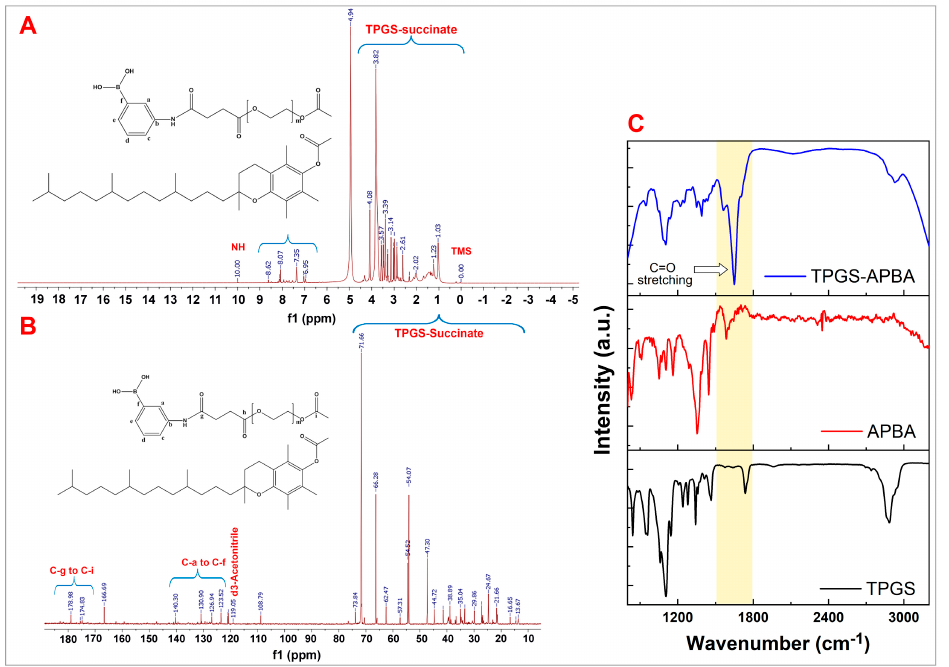
Figure 1. Characterization of functionalized TPGS using proton ( A ) and carbon ( B ) NMR (TMS— chlorotrimethylsilane). The right panel shows FT-IR spectral changes during APBA attachment ( C ).